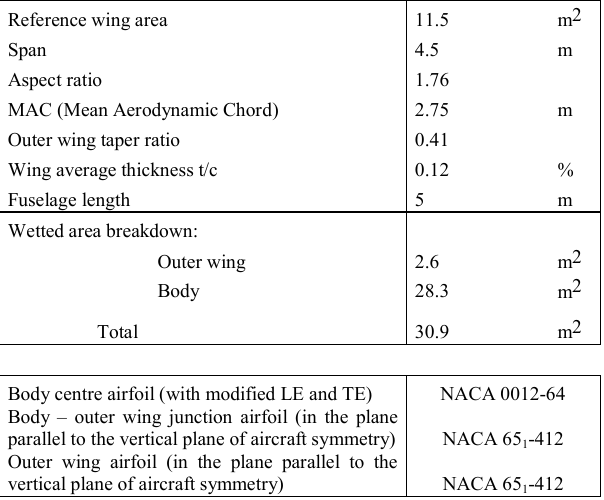
Fig 9. PW-124 – external layout. Control surfaces and air inlet are shown